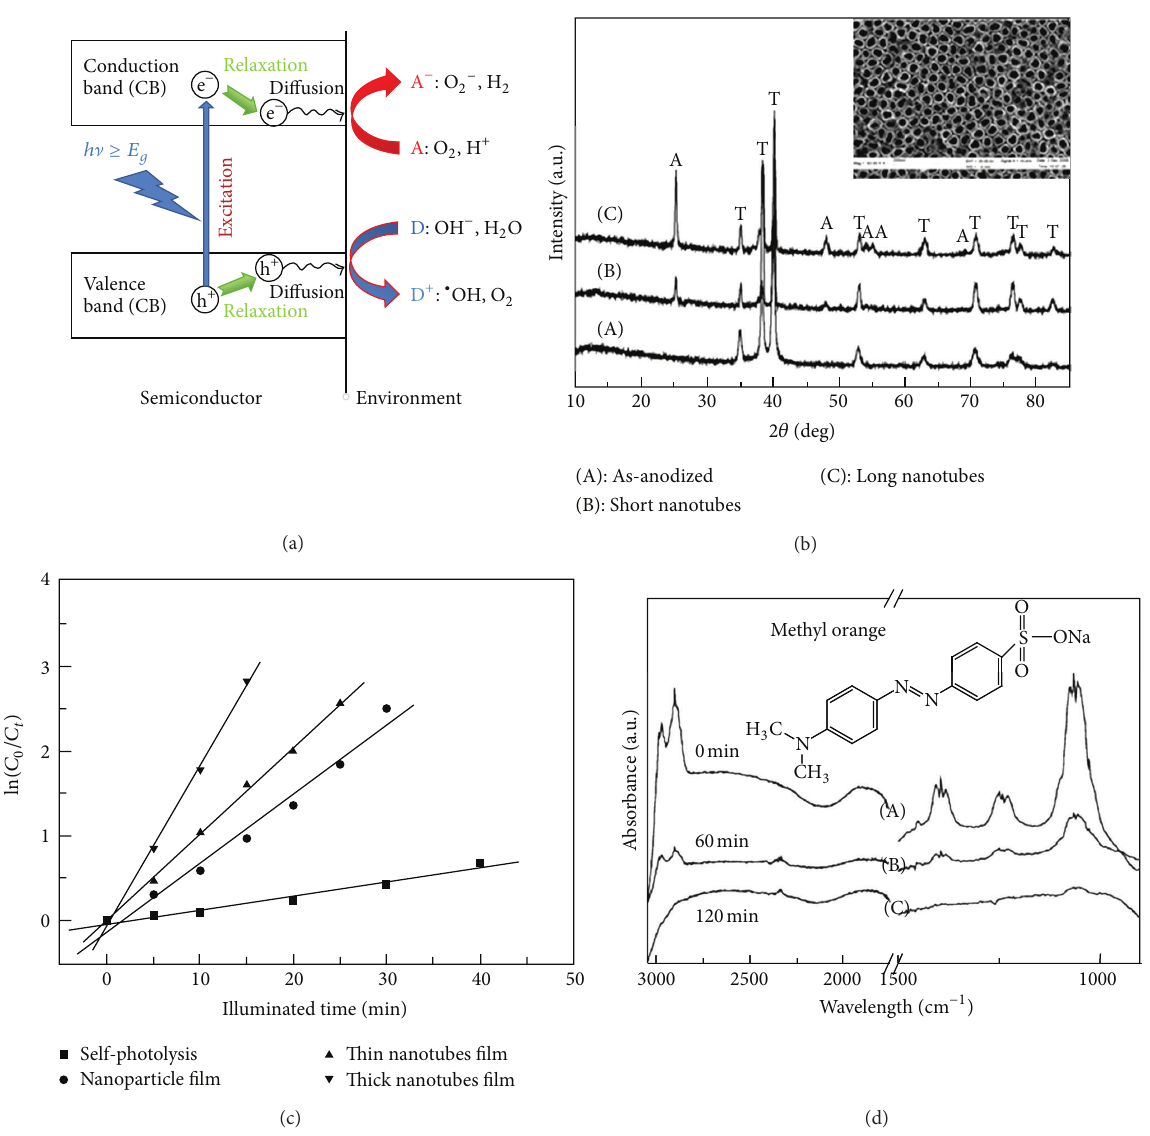
Figure 6: (a) Scheme of photo-induced processes at a TiO 2 semiconductor/electrolyte interface. Light (ℎ ] ) excites valence band electron to conduction band. Electrons and holes react with environment acceptor (A) and/or donor (D). (b) XRD patterns of TNAs film. (c) Comparison of photocatalytic degradation rates of MO for nanoparticle film and two different thicknesses of nanotubes films (A) under the high-pressure mercury lamp illumination. (d) ATR − IR spectra of MO before and after photocatalytic degradation.